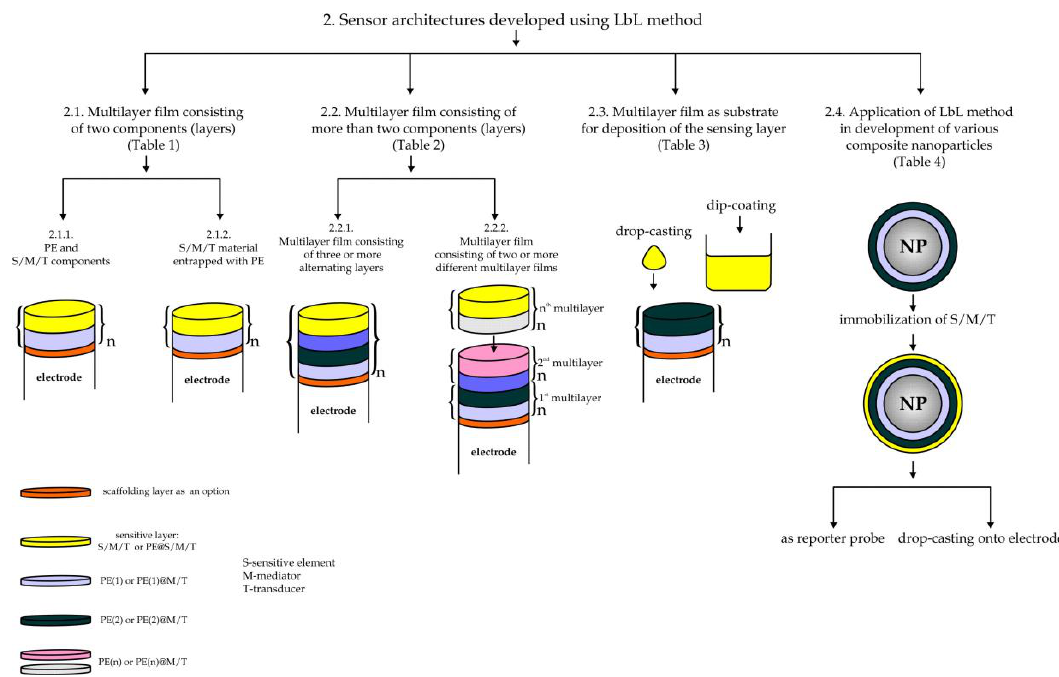
Scheme 1. A schematic overview of classification of sensor architectures obtained by using the layer-by-layer (LbL) method featured in articles covered by this review. Hints to the corresponding Tables are also given.